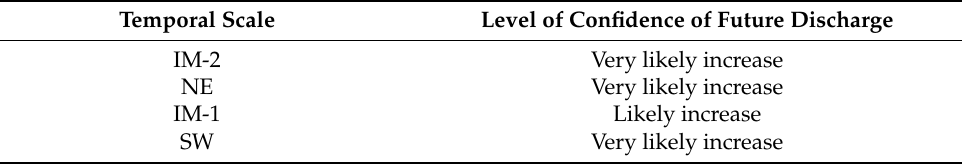
Table 5. Summary of seasonal discharges at Peradeniya discharge